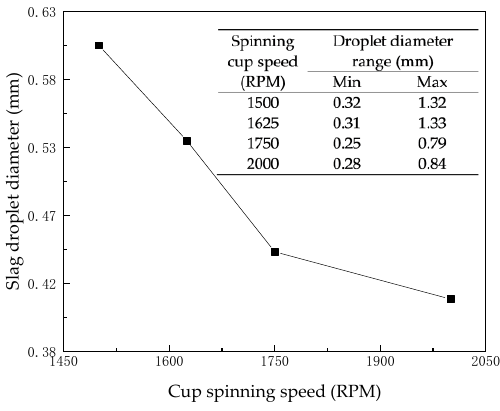
Figure 8. Effect of cup spinning speed on the average diameter of slag droplets.